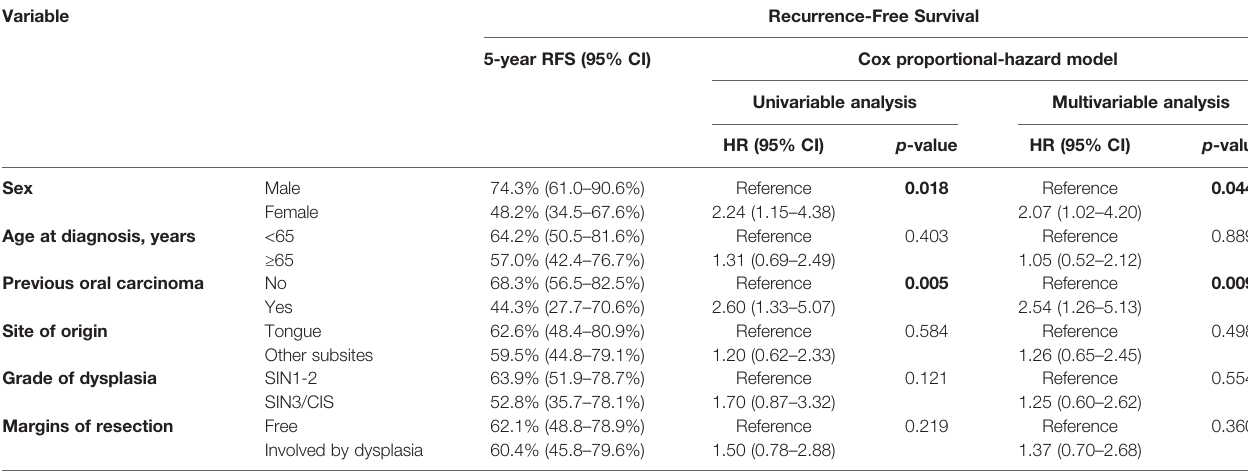
TABLE 3 | Uni- and multi-variable analysis of the most relevant demographics and clinical – pathological factors according to RFS (recurrence-free survival) and CFS (carcinoma-free survival).